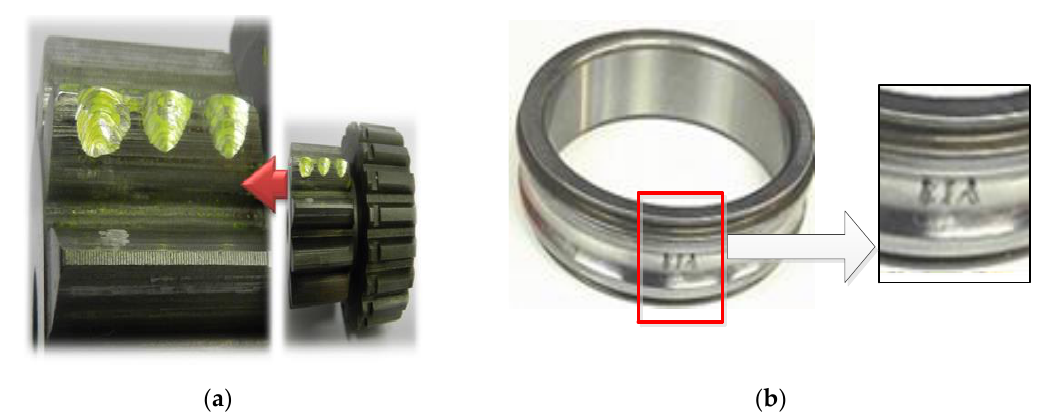
Figure 3. The measurement system.